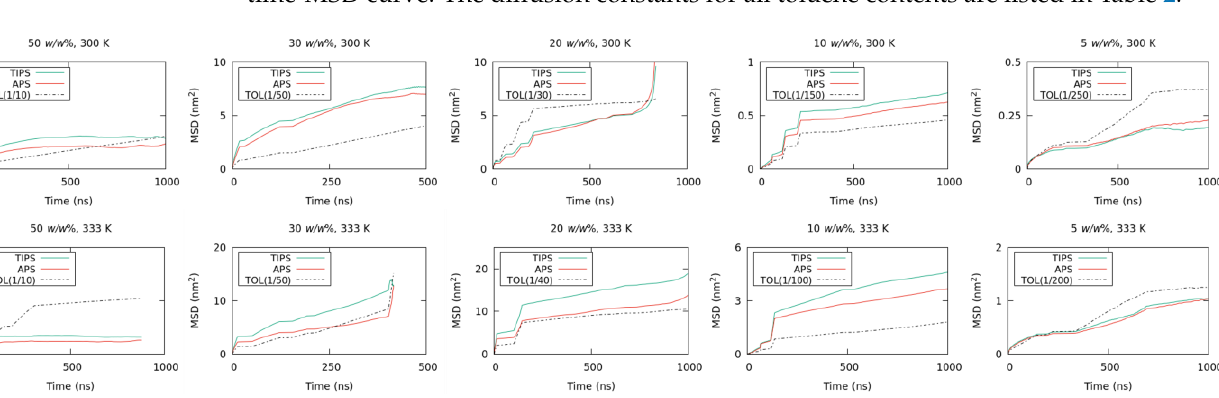
Figure 4. Time-dependence of the MSDs at different toluene contents and temperatures. TIPS-P (green), aPS (red), and toluene (black, dotted line). Table 2. Diffusion coefficients with standard error (sample size is 4) inside the bulk in the normal direction of the surface for toluene, TIPS-P, and aPS.